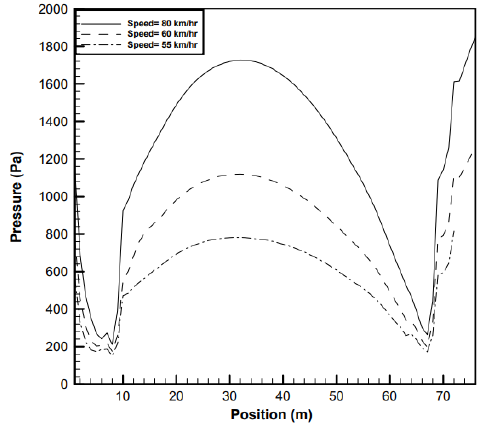
Figure 5. Pressure distribution along distance when the train head arriving the station area under various speeds [29].